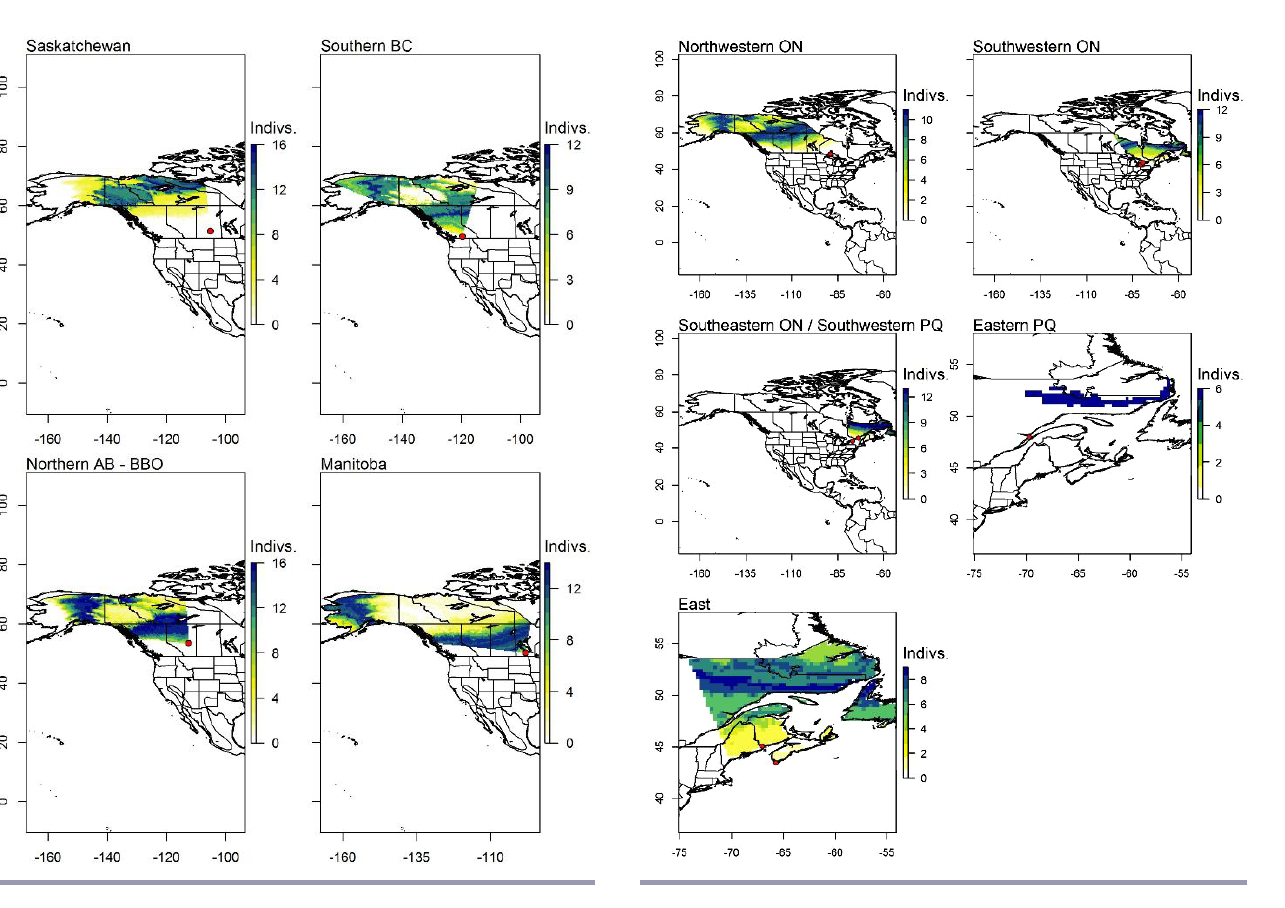
Fig. 6 . Probable origins of Yellow Warblers ( Setophaga petechia ) during fall migration continued. Red dots indicate locations of Canadian Migration Monitoring Network stations used in the analysis. Scales indicate the number of individuals that were isotopically consistent with similarly colored pixels in the map given.